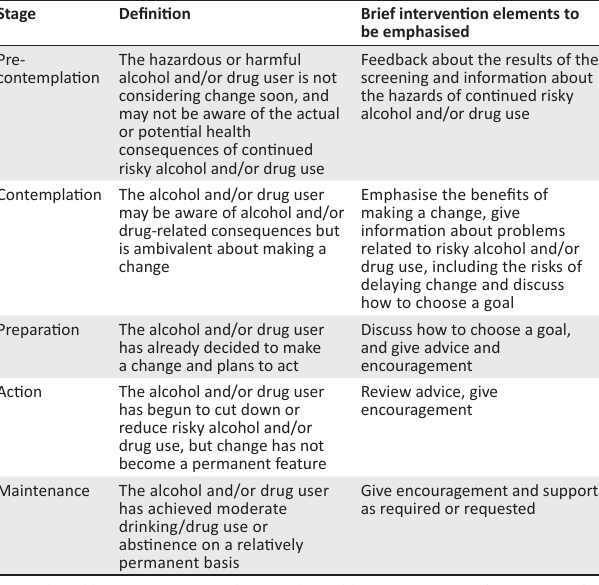
TABLE 10: Stages of change and recommended brief intervention elements.